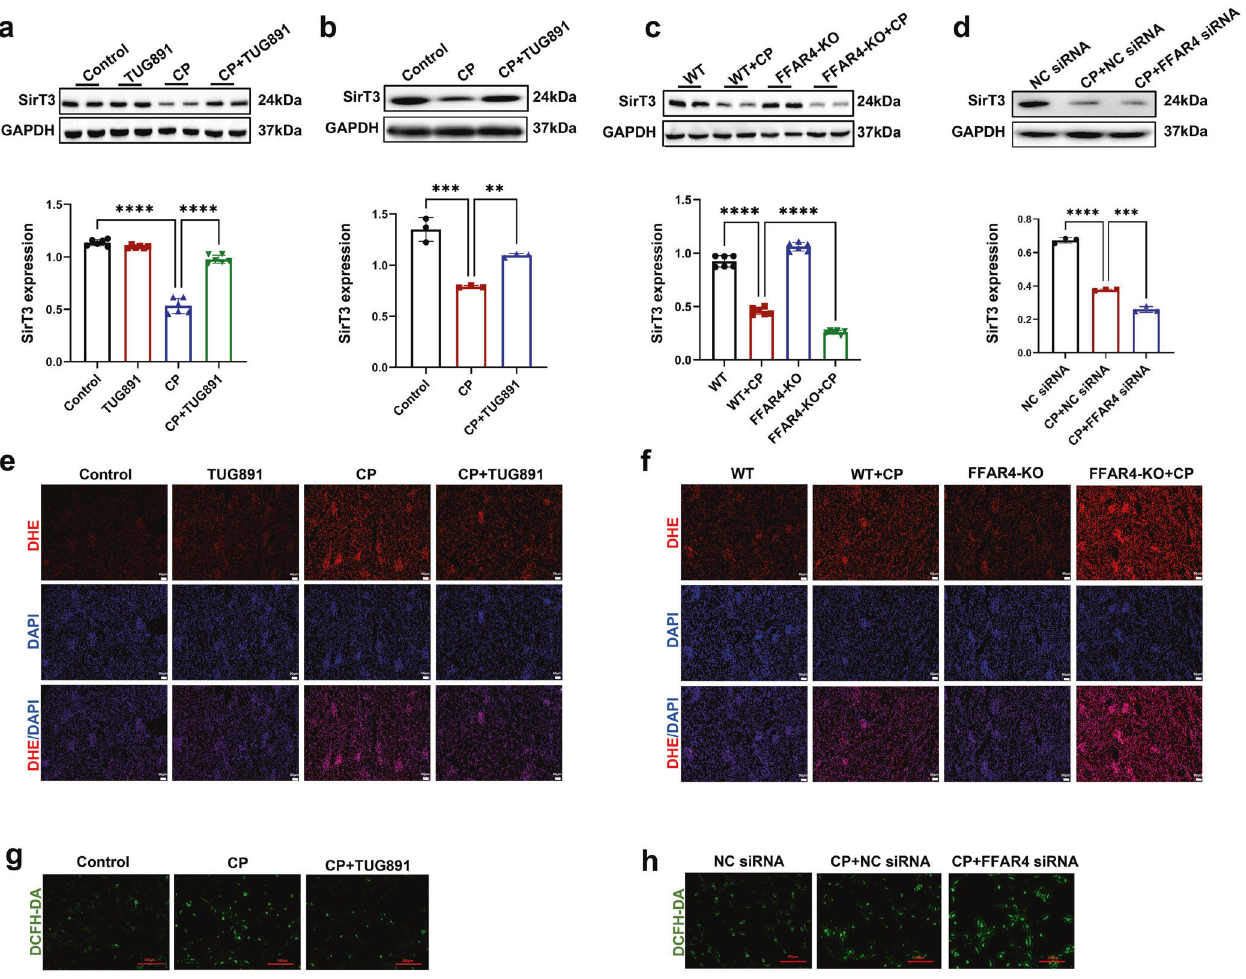
Fig. 7 Activation of FFAR4 reversed the decrease of SirT3 in cisplatin-induced AKI. a , c Protein expression of SirT3 in kidney tissues detected by western blotting and quanti fi ed by densitometry ( n = 6; **** P < 0.0001, * P < 0.05). b , d Protein expression of SirT3 in TCMK-1 cells detected by western blotting and quanti fi ed by densitometry ( n = 3; **** P < 0.0001, *** P < 0.001, ** P < 0.01). e , f The DHE staining of kidney sections (200×, scale bar = 50 μ m; 400×, scale bar = 20 μ m). g , h The ROS production in TCMK-1 cells was assessed by DCFH - DA staining (100×, scale bar = 250 μ m). Data are presented as mean ± SD. CP